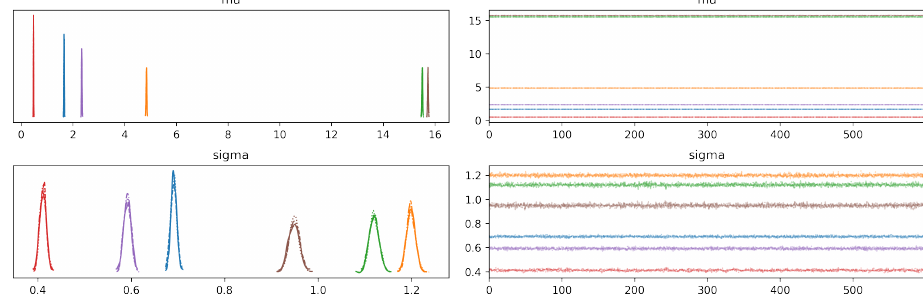
Figure 7. Posterior traceplot for houses and apartments model. Left part shows distributions of samples (samples values on x -axis and density on y ) and right part their values across the sampling process (samples number on x -axis and values on y ). For each parameter ( µ , and σ ), each color matches an element of the corresponding tensor (elements for hlc , base consumption and T s for each category). For each color, we plot a curve per sampling chain (4 in this case). All inferred variables sample values are displayed here regardless of their